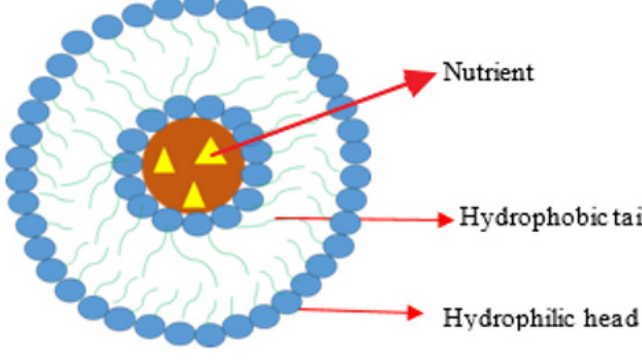
Figure 4. Liposome NP.